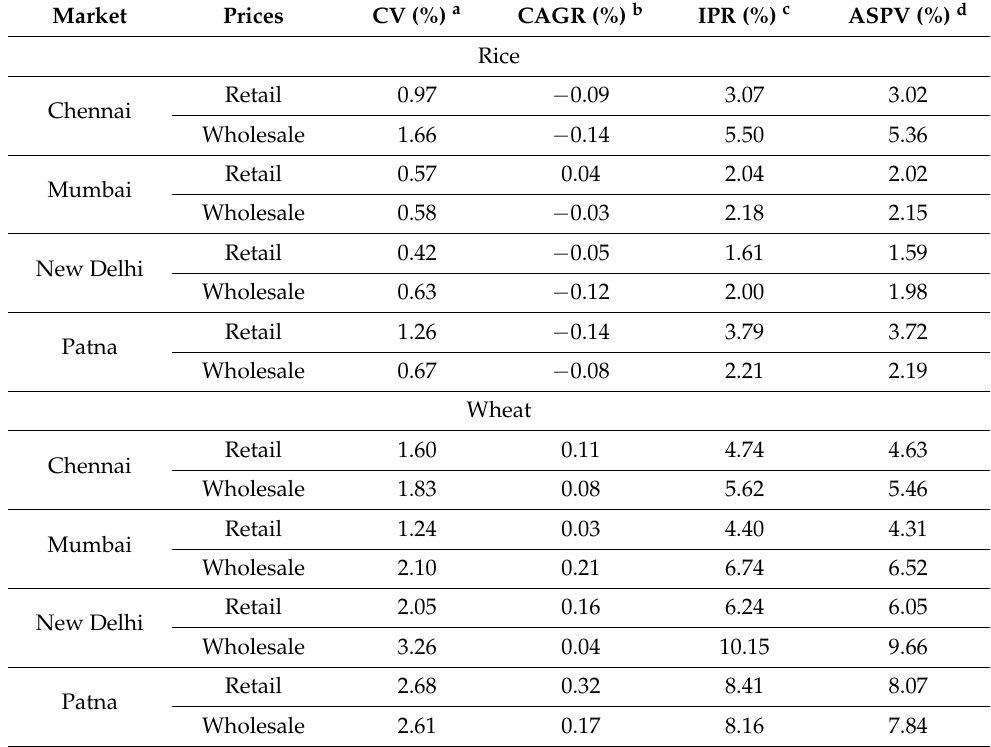
Table 3. Growth and variation in seasonal price index of rice and